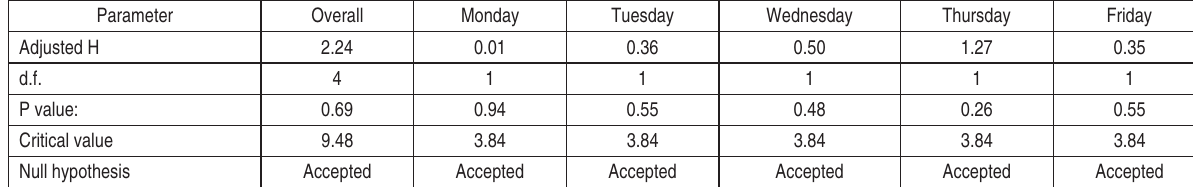
Table B8. Kruskal-Wallis test of the day-of-the-week effect for UX index